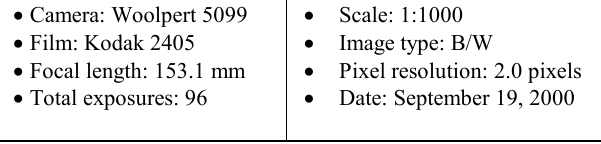
Table 2: Specification for aerial image data collection